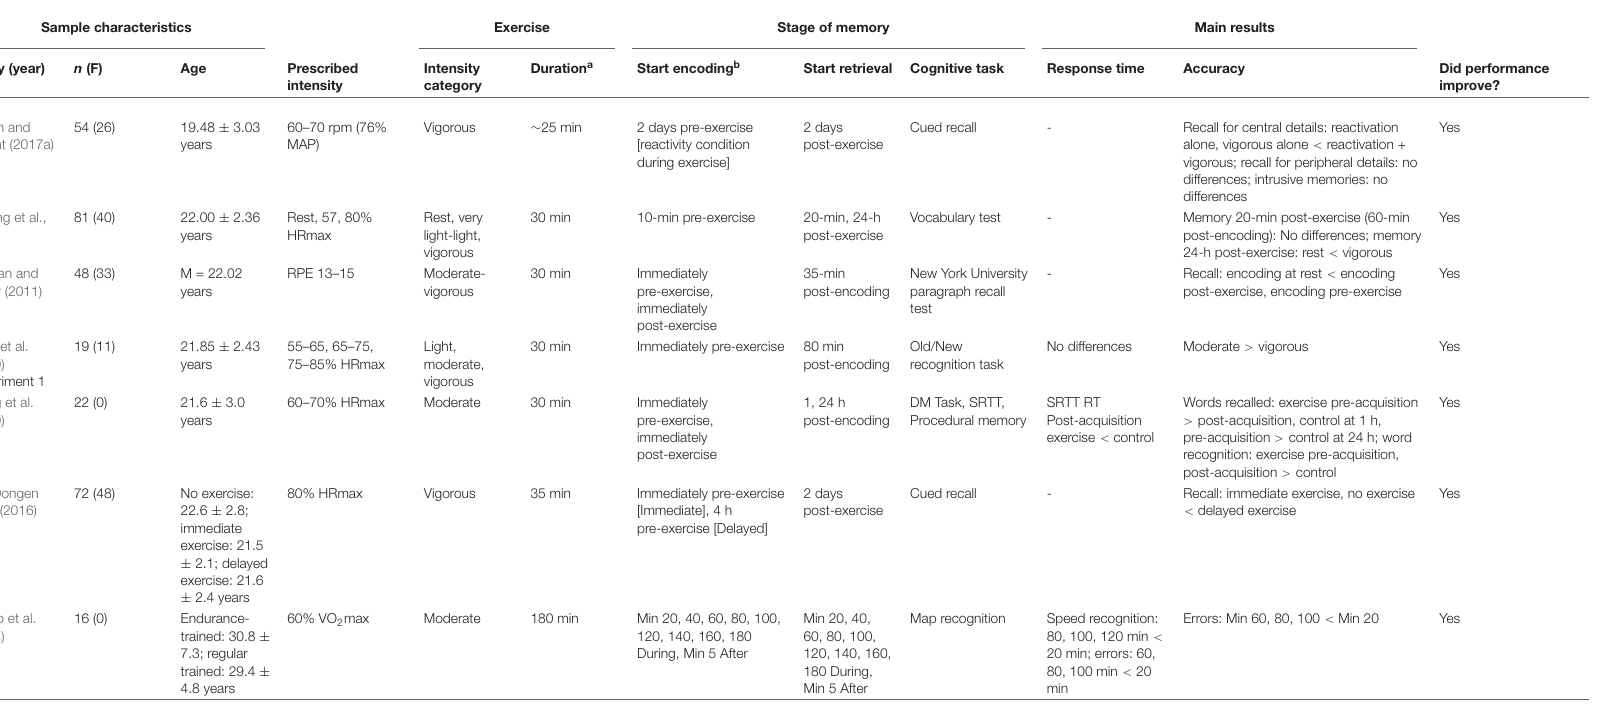
TABLE 7 | Summary of studies examining memory during acute aerobic